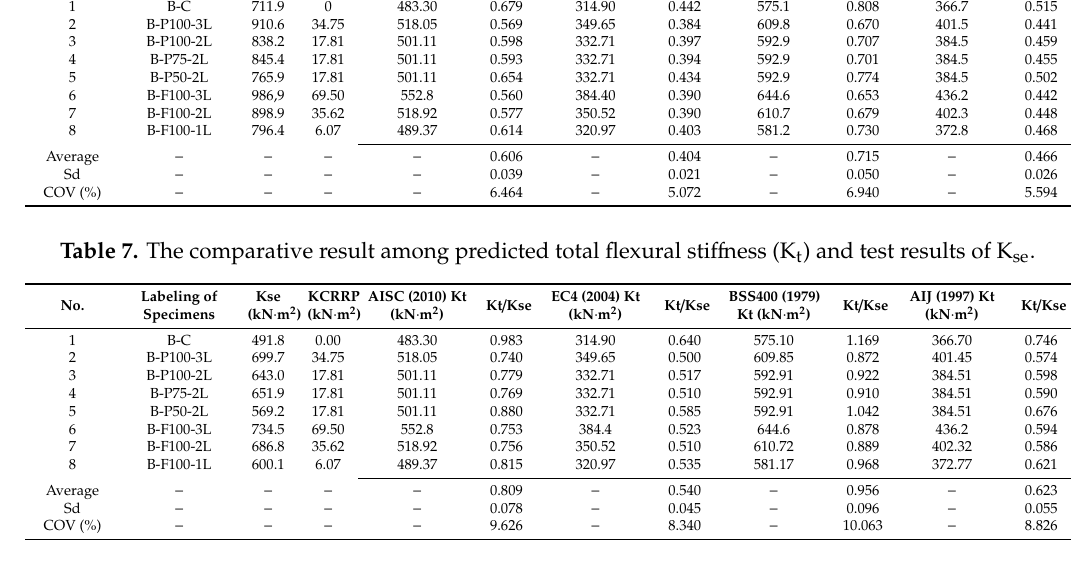
Table 6. The comparative result among predicted total flexural sti ff ness (K t ) and test results of K ie . No. Labelingof Specimens